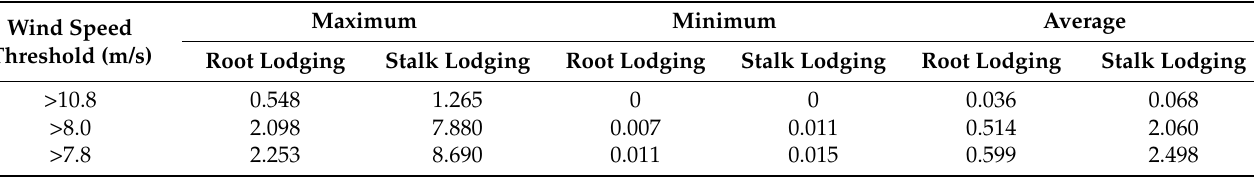
Table 5. The occurrence numbers of lodging